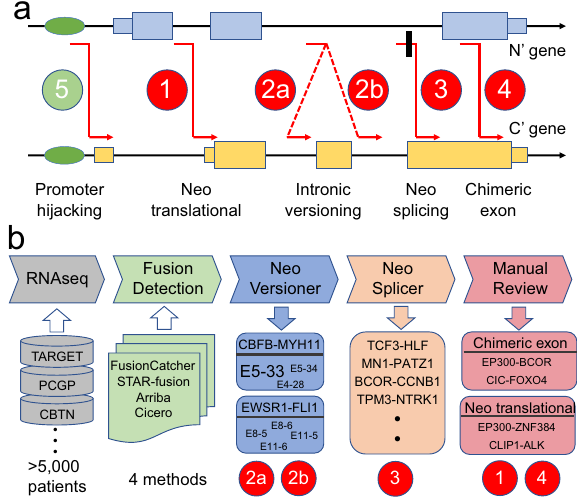
Fig. 1 | Model of fusion etiology and study design. a Theoretical mechanisms of oncogenicfusionformation.Scenario1:theDNAbreakpoints(redlines)canleadto the fusion of coding exons (thick boxes) from N ’ gene to 5 ’ untranslated region (UTR;thinboxes)ofC ’ geneandresultintheconversionofthecorrespondingUTR intocoding region, hence “ neo-translational ” . Scenario 2:the DNAbreakpointscan lead to thefusion of acoding exonfrom N ’ geneto multiplepossible codingexons ofC ’ gene,hence “ intronicversioning ” .Scenario3:theDNAbreakpointsfallinginto acoding exon maydisrupt the normalsplicesites, and the cancercellmayutilize a neo-splice site to ensure the inclusion of the corresponding exon, hence “ neo- splicing ” . In this scenario, a cryptic exon (black box) might be created. Scenario 4: the DNA breakpoints may directly fuse two coding exons, hence “ chimeric exon ” . Scenario 5: a well-known phenomenon is promoter/enhancer hijacking, which is not studied in this work because it does not lead to chimeric protein. b . Study design. We analyzed tumor RNA sequencing data using four fusion detection methods, and classi fi ed the detected fusions into intronicversioning,neo-splicing, neo-translational, and chimeric exon (see